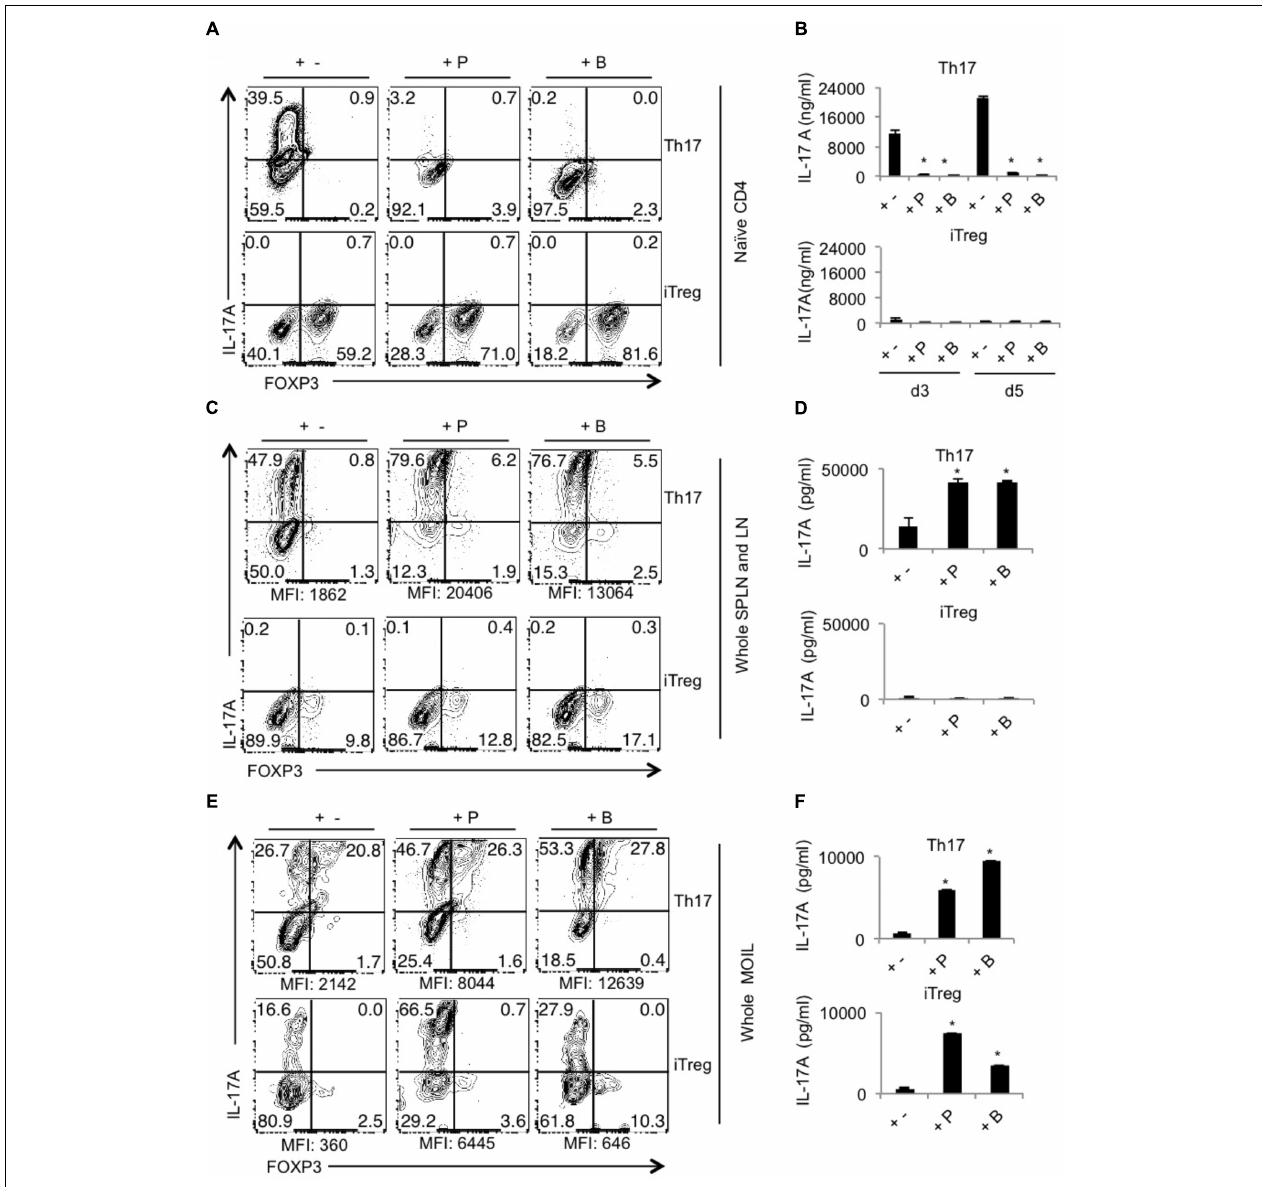
FIGURE 4 | SCFAs promote IL-17A and Foxp3 expression, depending on cytokine milieu in vitro. Naïve cells from normal WT mice were isolated from pooled SPLN and all lymph nodes. They were stimulated with T cell depleted APC under Th17 conditions (upper panel) or iT reg polarization conditions (lower panel) with or without propionate (P) and butyrate (B). (A) IL-17A and Foxp3 expression (in CD4+ cells) were assessed by flow cytometry on day 4 after stimulation. (B) Supernatants were collected on days 3 and 5, and IL-17A levels were measured by ELISA. (C,D) Single cells suspensions were derived from pooled SPLN and all lymph nodes and were stimulated under Th17 conditions (upper panel) or iT reg polarization conditions (lower panel) with or without propionate (P) and butyrate (B). Flow cytometric assessment of IL-17A and Foxp3 expression on day 4 are shown in (C) . ELISA quantification of IL-17A in culture supernatants on day 4 is shown in (D) . ( E,F ) Single cells suspensions were derived from MOIL and were stimulated under Th17 conditions (upper panel) or iT reg polarization conditions (lower panel) with or without propionate (P) and butyrate (B). Flow cytometric assessment of IL-17A and Foxp3 expression on day 4 are shown in (E) . ELISA quantification of IL-17A in culture supernatants on day 4 is shown in (F) . ∗ P < 0.05, as measured by Mann–Whitney tests. Data represent three independent experiments. Geometric mean fluorescence intensities of IL-17A expression in CD4+ cells are shown as MFI in flow cytometric plots in (C,E)